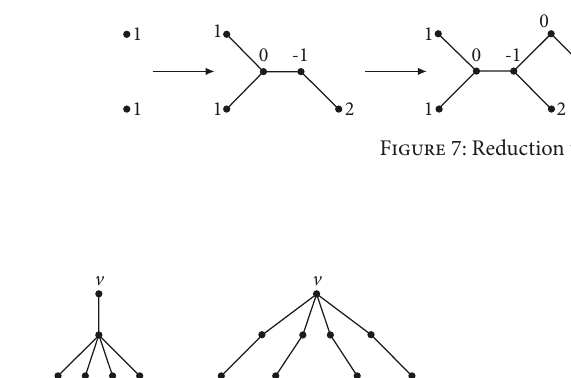
Figure 8: Complex structures that can be reduced when 𝑚 = 3 .